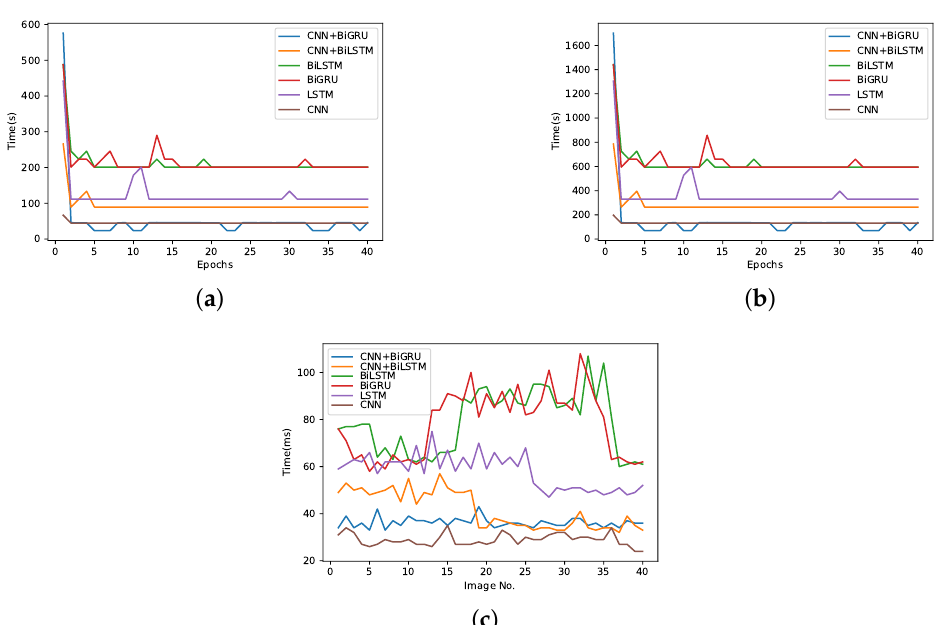
Figure 8. Computation complexity analysis that represents how much time is taken by various models to train for 40 epochs and the time taken to give an inference on a single sample. ( a ) Training Time vs. Epochs (No Augmentation). ( b ) Training Time vs. Epochs (With Augmentation). ( c ) Inference Time vs. Image No. (Id).